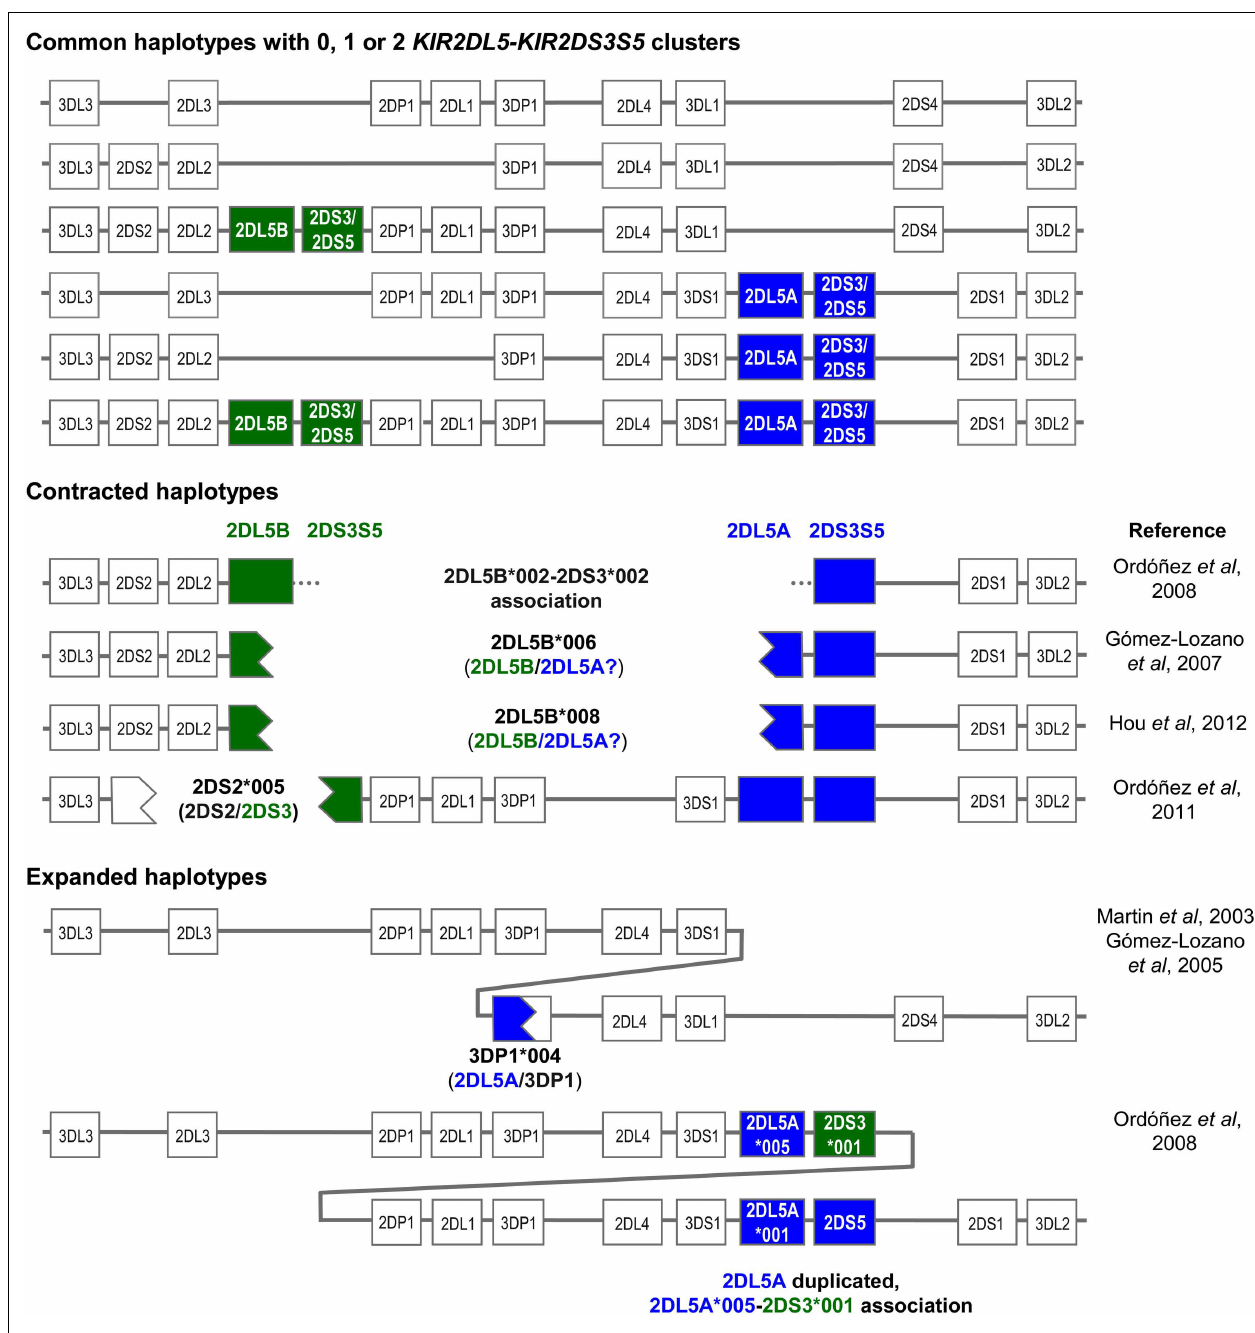
KIR2DL5B predominate in Mongoloid and Black